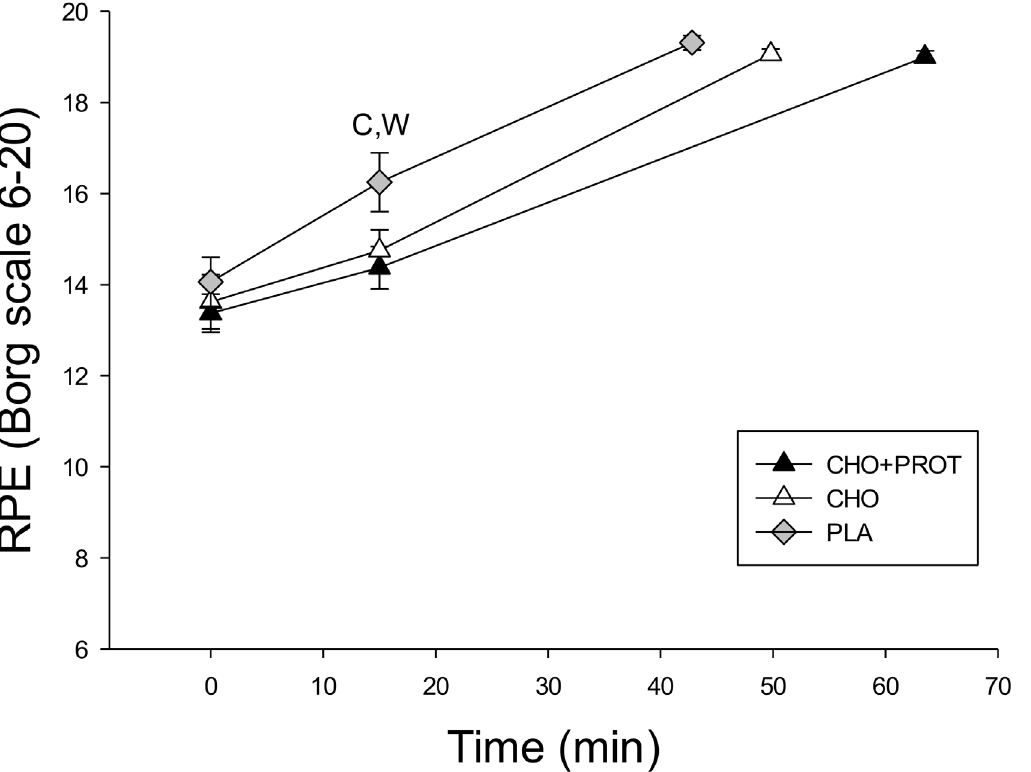
Fig 9. Rate of perceived exertion (RPE) during the time to exhaustion (TTE) performance test after the three diet interventions. Data are mean and error bars represents SEM. C: p < 0.05 compared to CHO; W: p < 0.05 compared to CHO+PROT (whey); P: p < 0.05 compared to placebo. N = 8 for all data